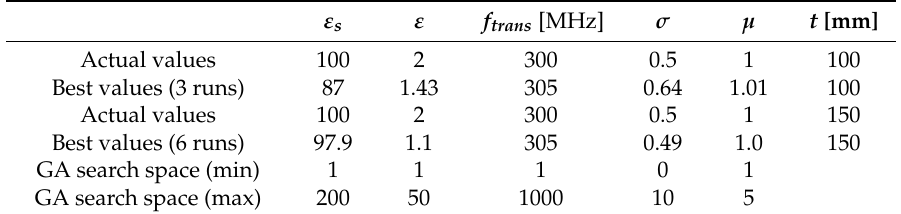
Table 1. Electrical and geometrical parameters of the material characterised by a Debye dispersion. ε s ε f trans [MHz] σ